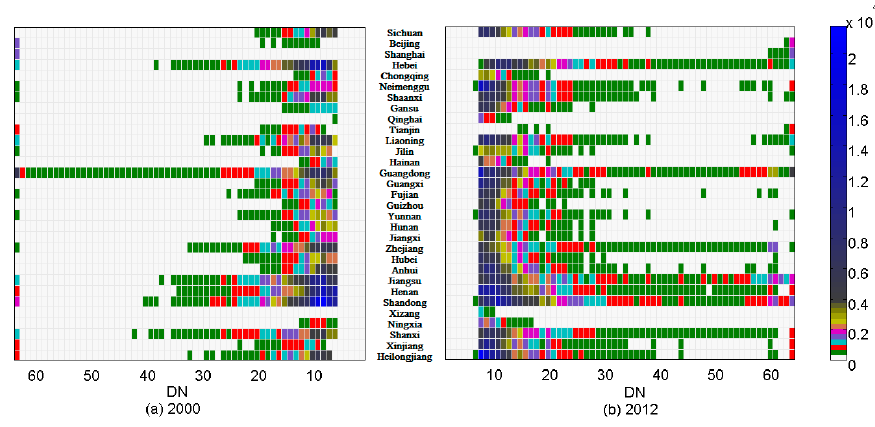
Figure 2 . Distribution of frequency table of the entire DN series in ( a ) 2000 and ( b ) 2012.